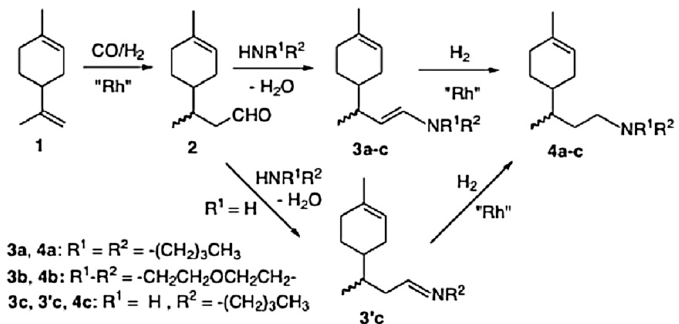
Figure 9. Reaction scheme of the hydroaminomethylation of limonene ( 1 ) with ammonia using [Rh(cod)Cl] 2 catalyst. Reprinted from [77] with permission from Willey.